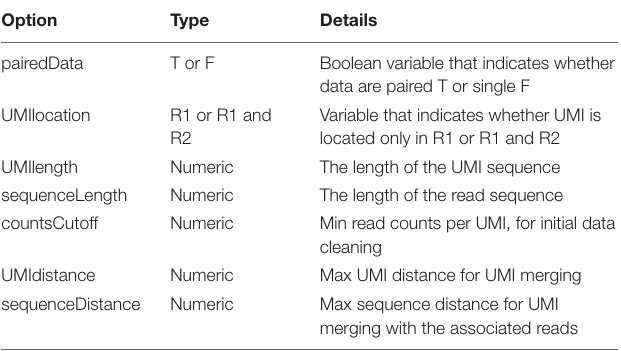
TABLE 1 | Selected criteria being input from the